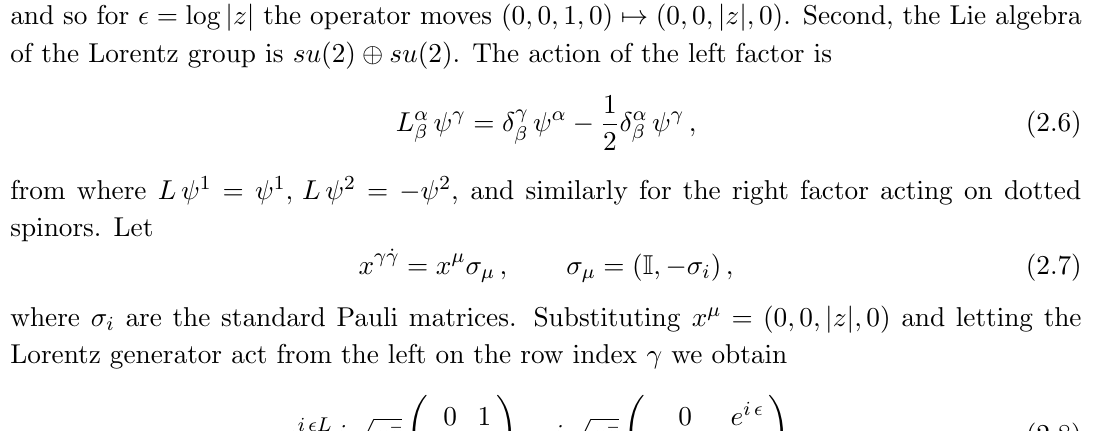
Figure 3 . Starting from three points in canonical positions 0, 1 and 1 we can move the point 1 into the complex plane. First we act with the dilation generator D , moving the point to z (green arrow). Then, we perform a rotation generated by J by the angle arg( z ) = (cid:0) i